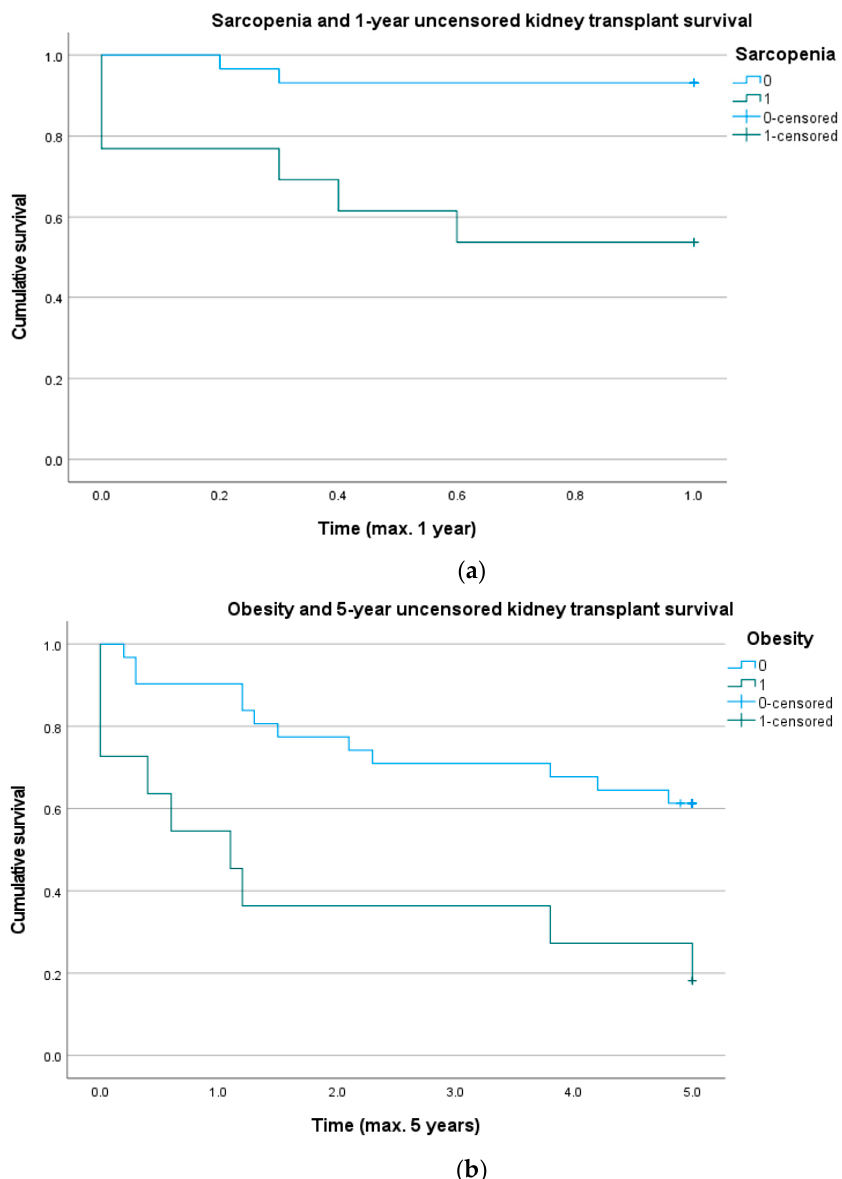
Figure 2. ( a ) Graph showing that sarcopenia assessed by a routine pretransplant computed tomography (CT) scan may influence 1-year uncensored graft survival. Log rank test: p = 0.002. ( b ) Graph showing that obesity may influence 5-year uncensored graft survival. Log rank test: p = 0.007.